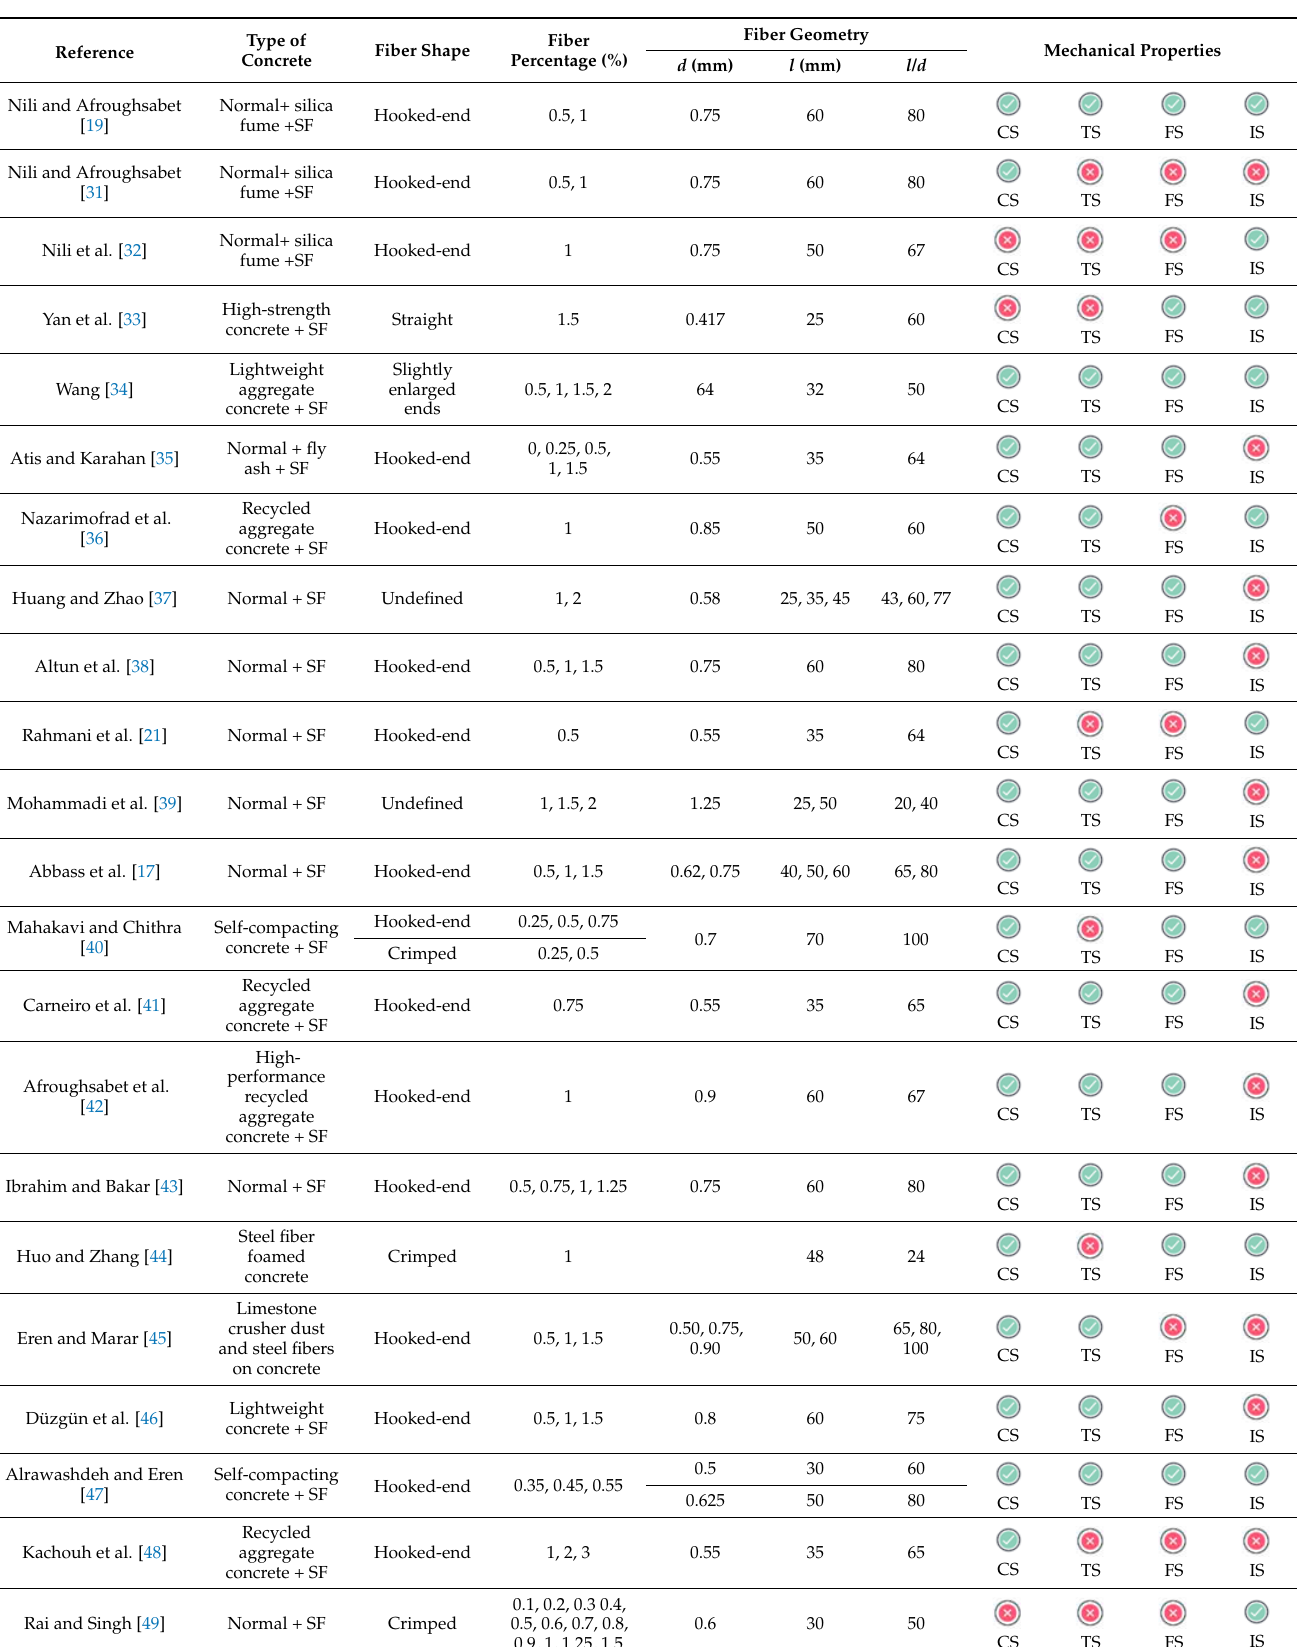
Table 1. Information on previous studies.